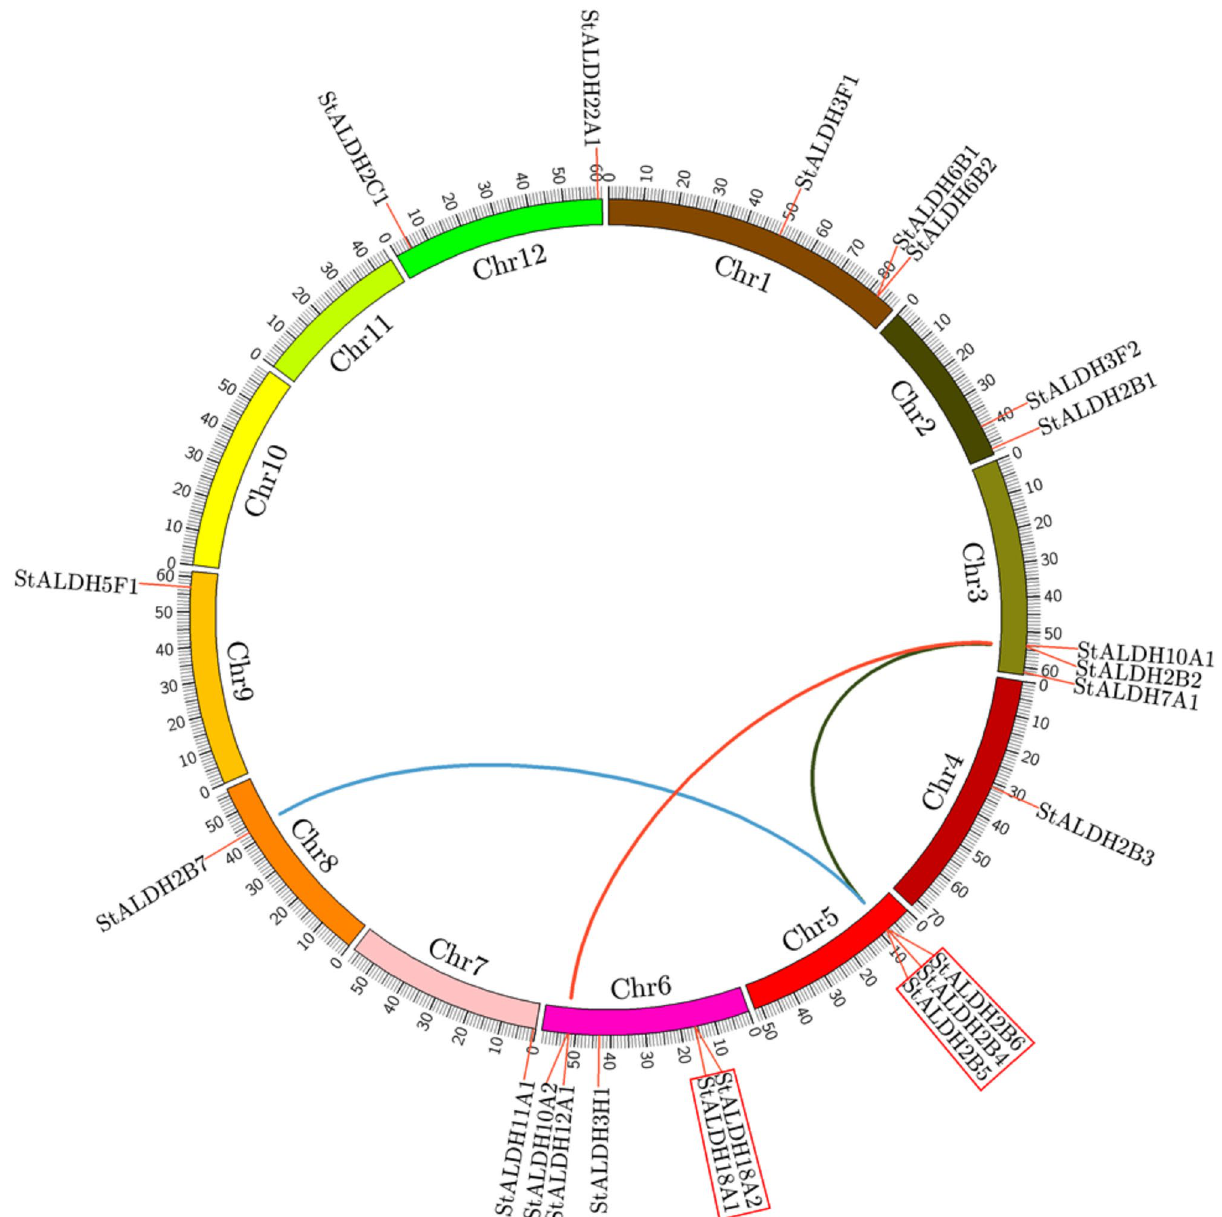
Figure 2. Chromosomal localization and gene duplication of StALDH genes. All the identified putative 22 StALDH genes were indicated on 12 different chromosomes of potato by red labels. Potato chromosomes (Chr1-Chr12) were depicted with different colour bars generated by Circos software (http:// circos. ca/). The scale along with each chromosome indicates their respective genomic size. Three WGD/segmentally duplication gene pairs were connected by red, dark green, and blue lines. Tandem duplication events were indicated by a red box outside the gene